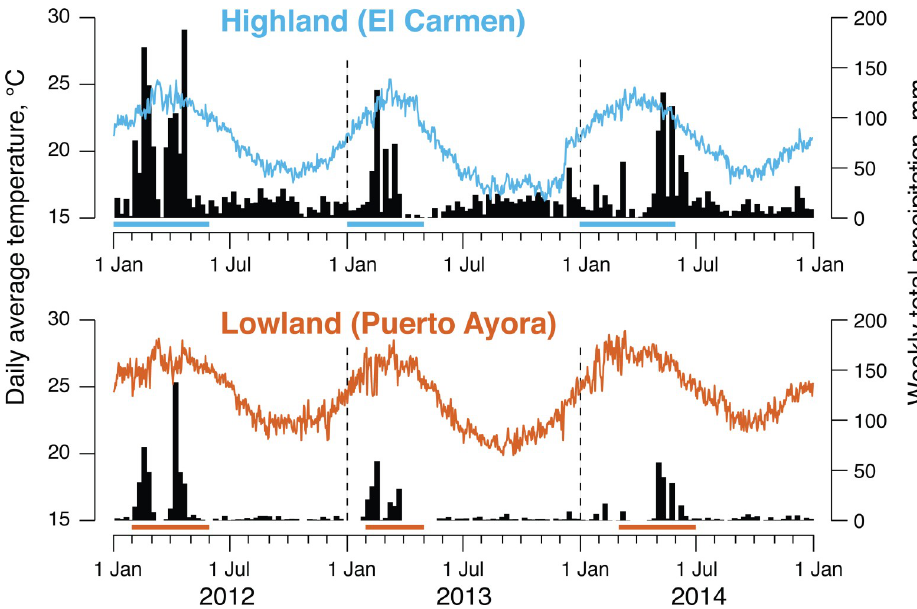
Fig 1. Daily average air temperatures and weekly precipitation totals recorded near the highland study site and the lowland study site on Santa Cruz Island, 2012–2014. Horizontal bars above calendar scales represent breeding seasons of known hosts (B. Fessl, pers.